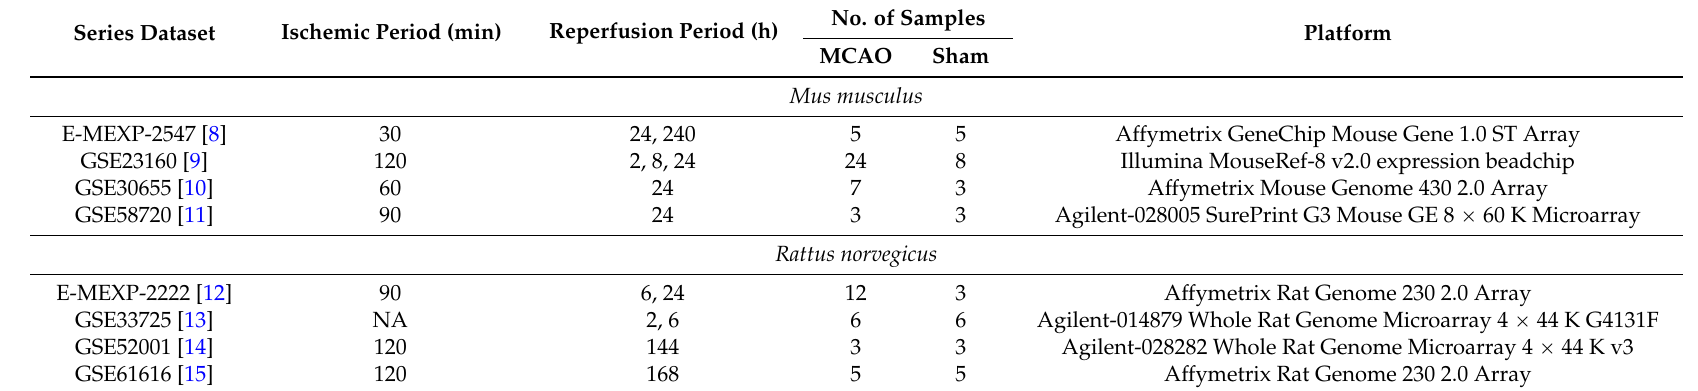
Table 1. Characteristics of included studies analyzed in the